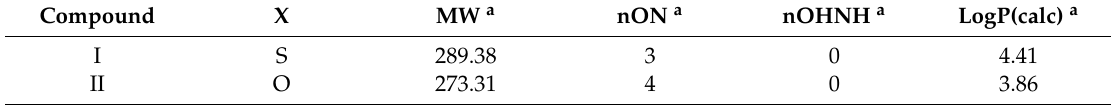
Figure 1. General structure of studied compounds: Benzyl 4-nitrobenzenecarbodithioate ( I ) and 4-nitrothiobenzoic acid S-benzyl ester ( II ). Table 1. Studied compounds and physicochemical properties.